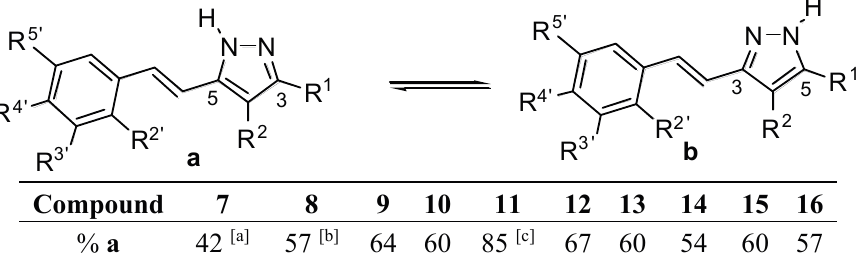
Table 2. Proportion of tautomer a ( b = 100 − a ) for pyrazoles 7 to 16 in DMSO- d 6